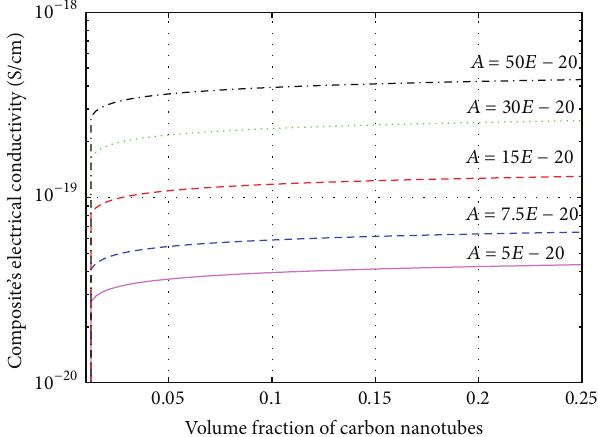
Figure 2: Maximum packaging fraction of the filler used in the composite versus aspect ratio of the filler involved.